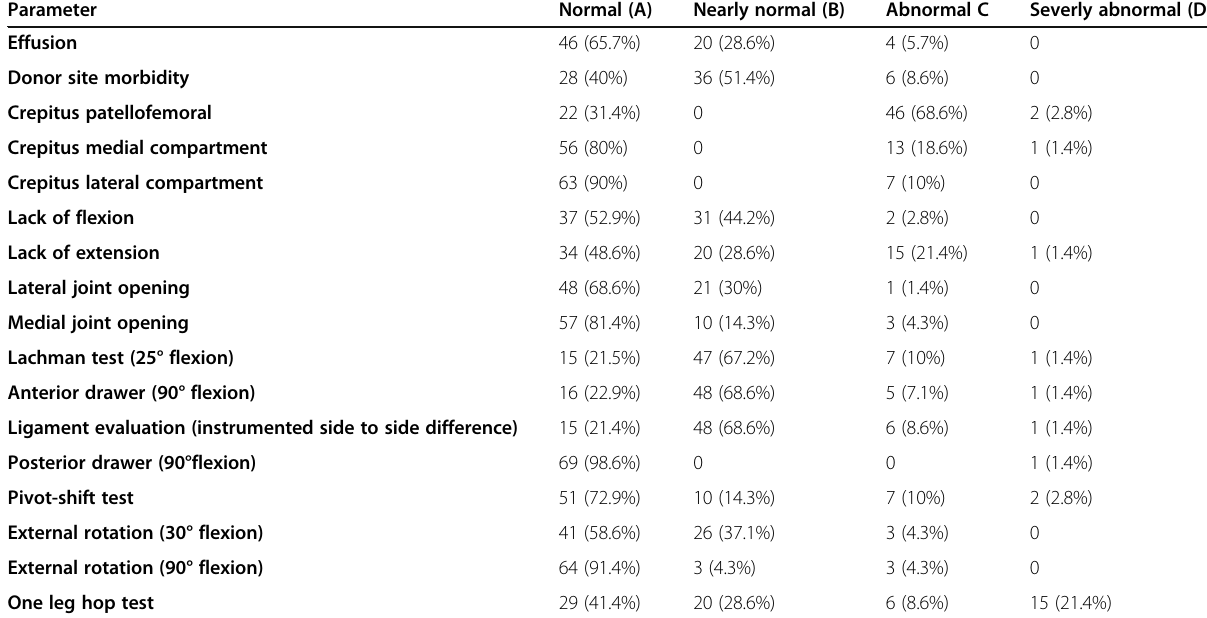
Table 2 Number of patients and percentage of each parameter according to IKDC Parameter